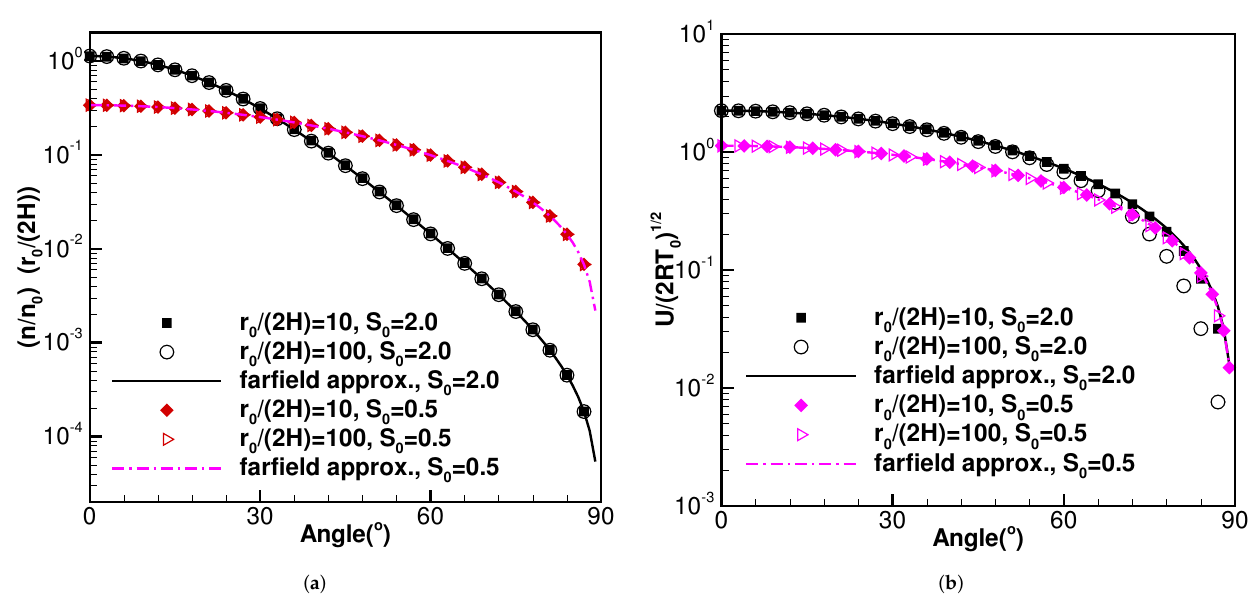
Figure 2. ( a ) Normalized farfield density profiles, n 1 ( X , Y )